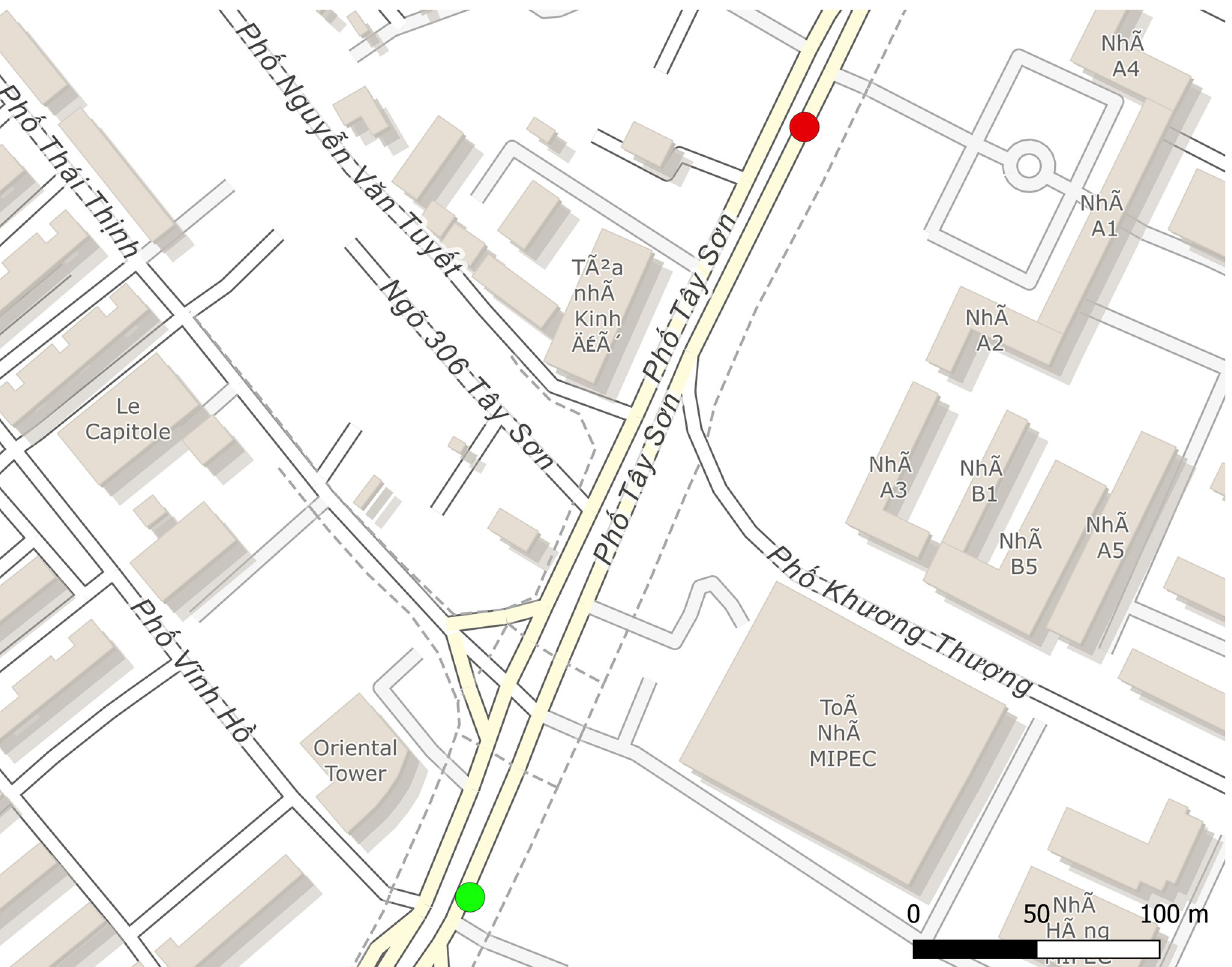
Fig 4. Tay Son street site (based on OpenStreetMap data): The green circle represents the input point (WGS84 coordinates: (105.8224 21.005)), and the red circle the output (WGS84 coordinates: (105.8236 21.0076)).